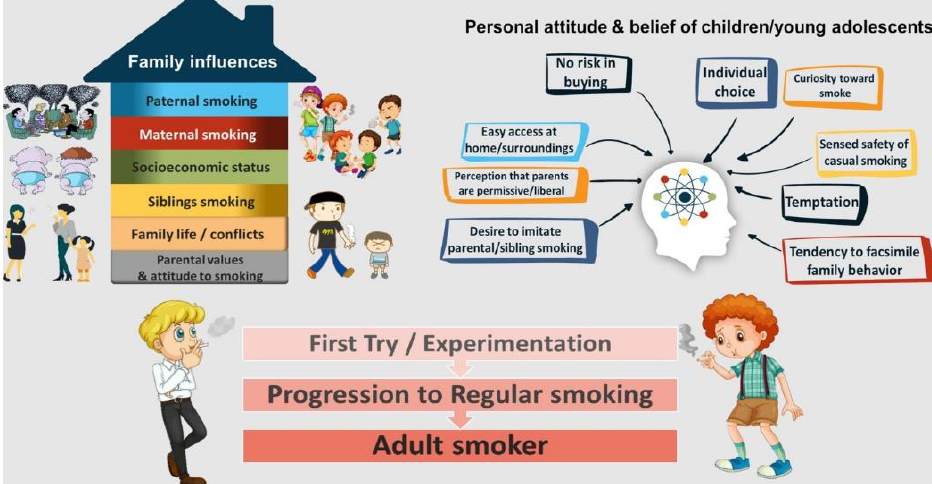
Figure 1. Family influence and intergenerational transmission of tobacco addiction behavior.